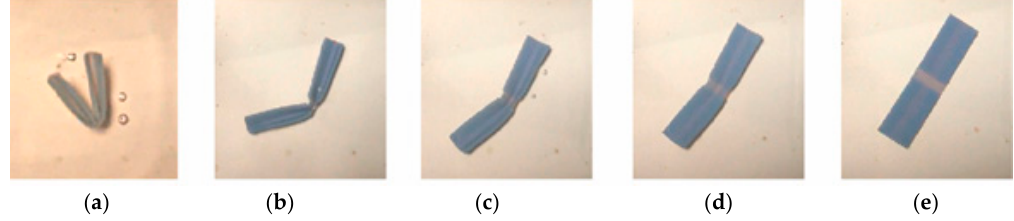
Figure 15. Method 1—the sequence of unfolding for 0.5 mm sample. ( a ) Unfold along folding line 1; ( b ) Continues to unfold; ( c ) Unfold along folding line 1 and unfold along folding line 2; ( d ) Continue to unfold along both folding lines; ( e ) Fully unfolded specimen.